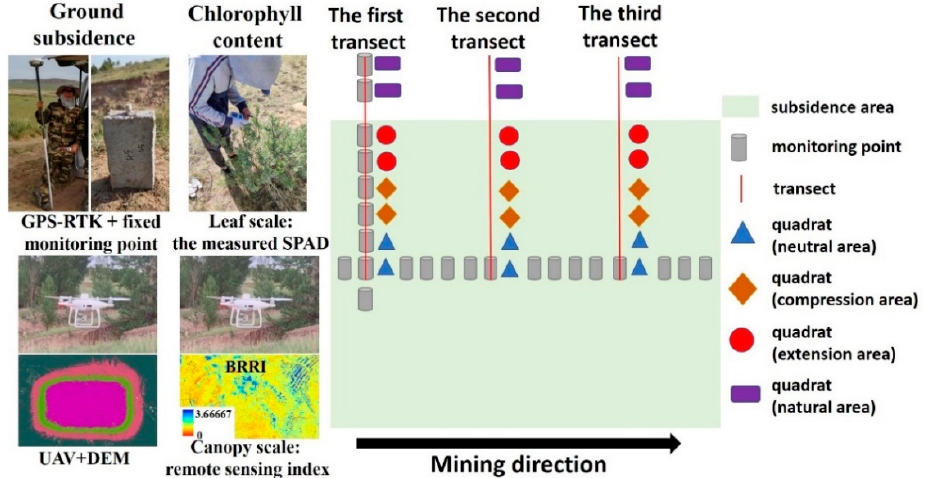
Table 1. Working face parameters and mining parameters.